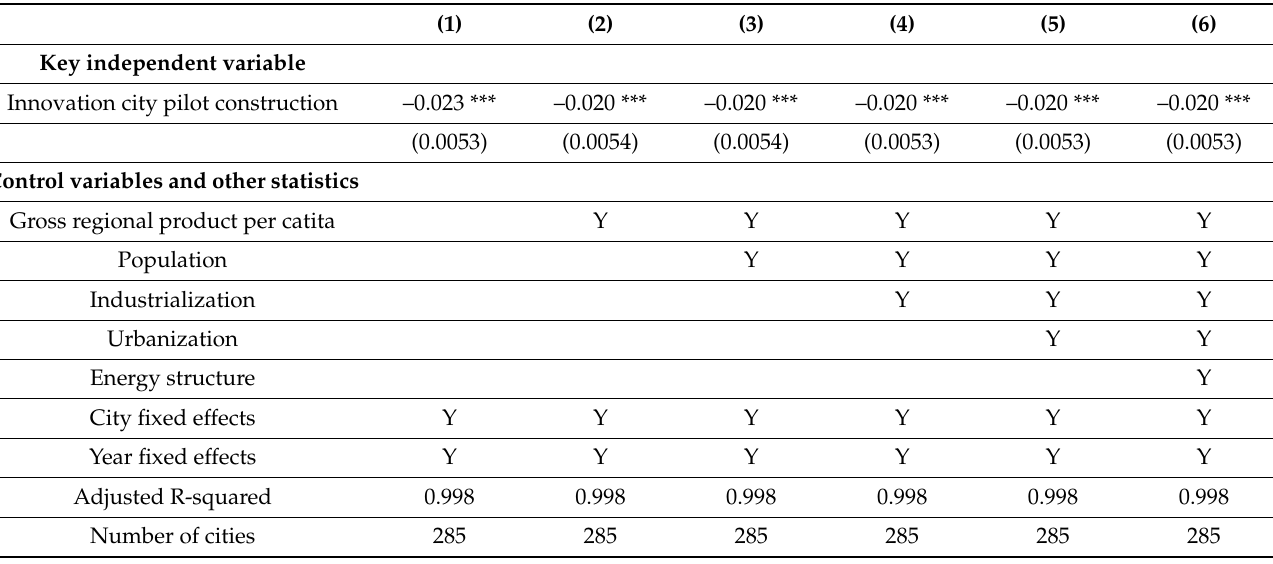
Table 2. Estimates in the impact on carbon emissions from propensity-score-matching difference-in- differences